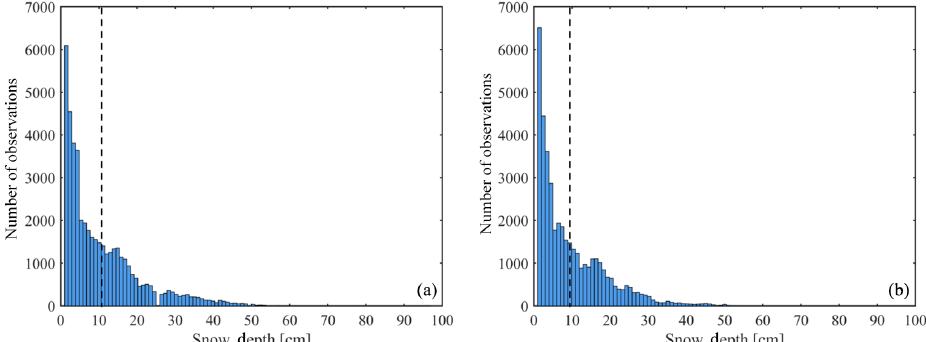
Figure 2. Histograms of snow depth observations from (a) training and (b) validation stations. The average values (black dashed lines) are equal to 10.5 and 9.8cm,